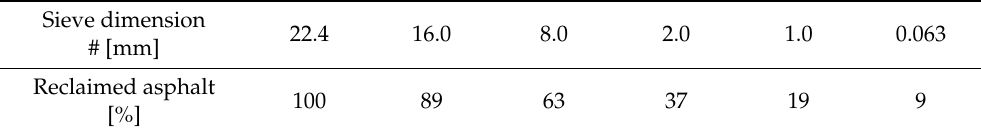
Table 5. Graining of reclaimed